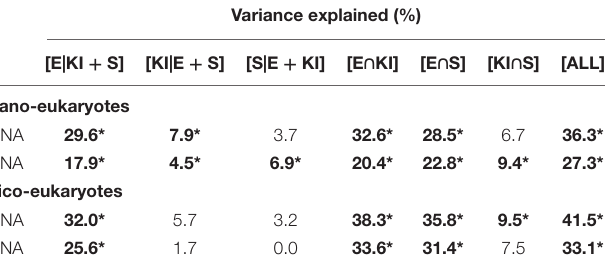
The bold font and asterisk indicate significant level at p <